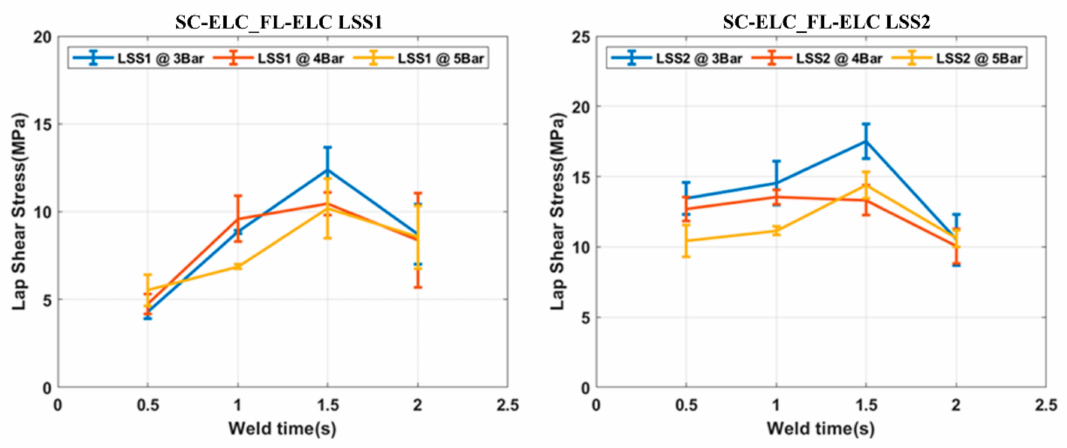
Figure 13. LSS1 and LSS2 graphs for SC-ELC_FL-ELC